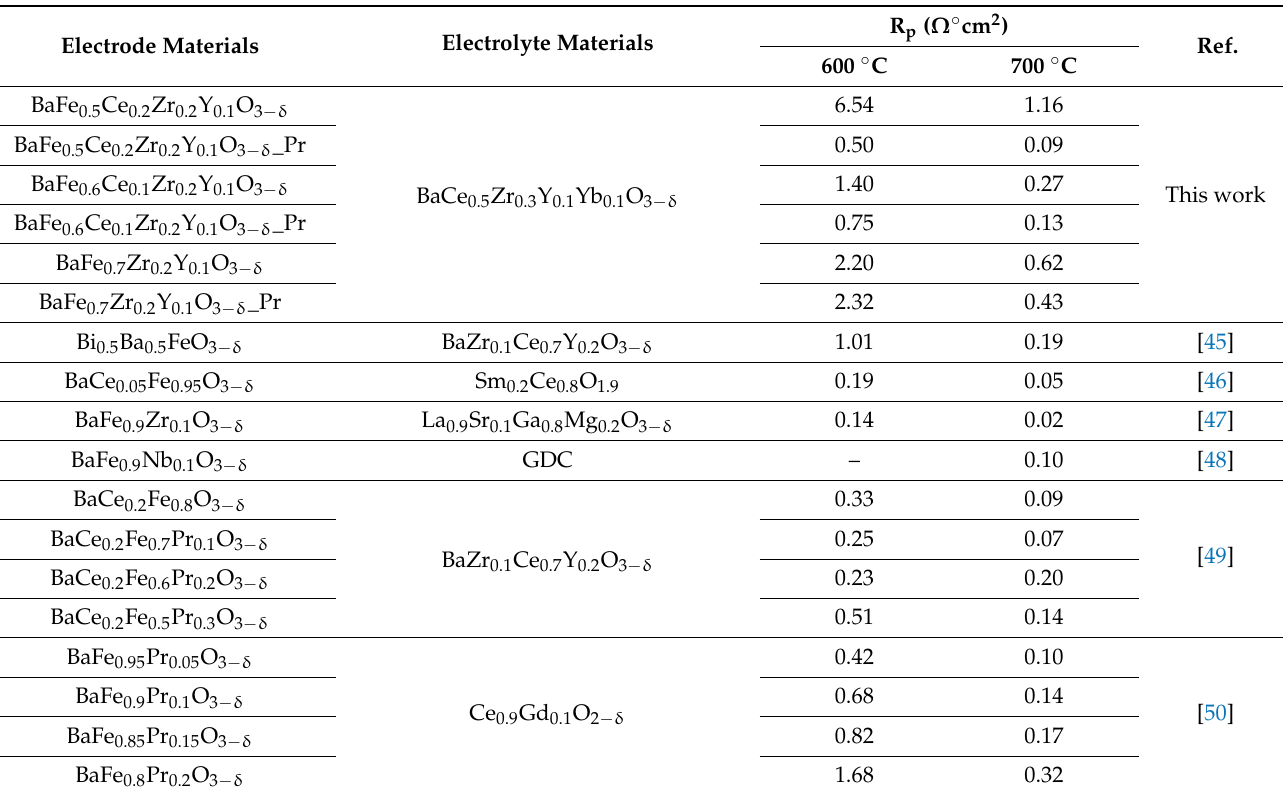
Table 1. Polarization resistances of BaFeO 3 -based electrodes obtained for SDCs with an elec- trode|electrolyte|electrode